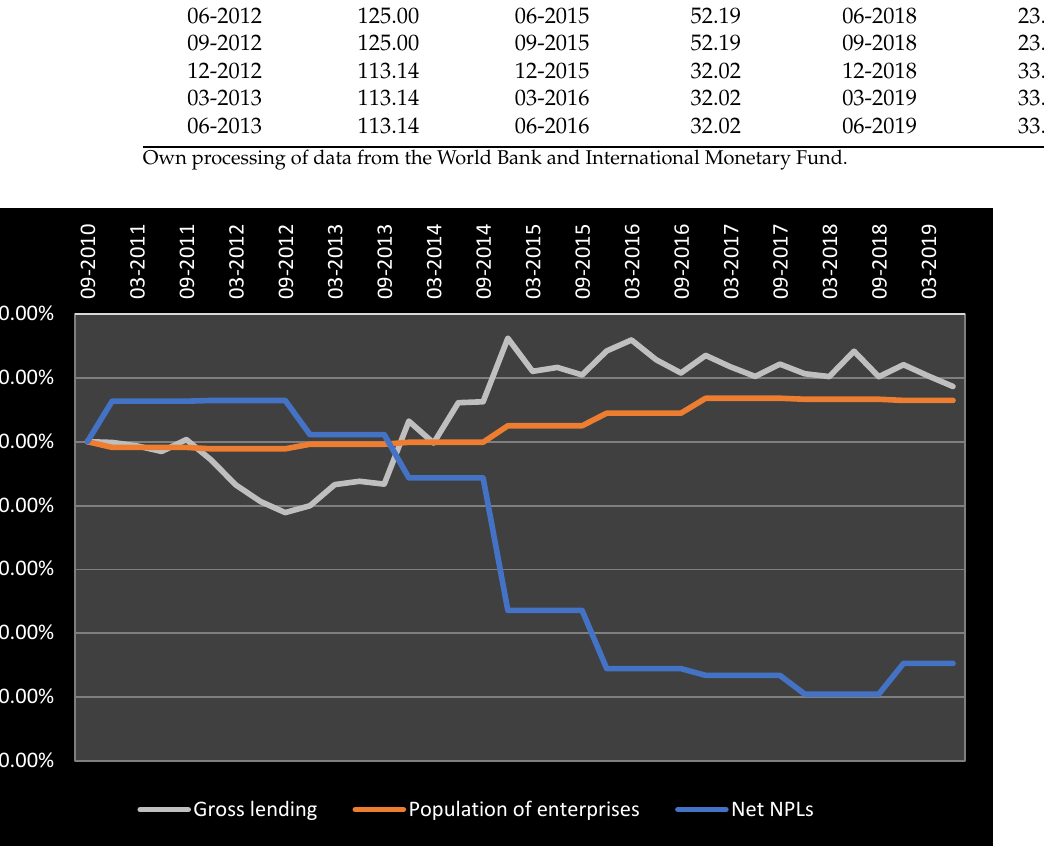
Figure 2. Percentage changes in credit disbursed, population of enterprises in the market and number of NPLs in the United Kingdom from September 2010 to March 2019. The graph shows a general decline in net NPLs in the UK from September 2010 to March 2019, dropping sharply in 2014 and falling by 70.00% by March 2019. The population of enterprises remains relatively unchanged until September 2014, after which there is a gradual increase of about 15.00% by March 2019. Gross lending declines 20.00% by September 2012, then rises 50.00% by September 2014, before fluctuating regularly to reach 20.00% above September 2010 levels in March 2019. Based on data in Tables 6 – 8.